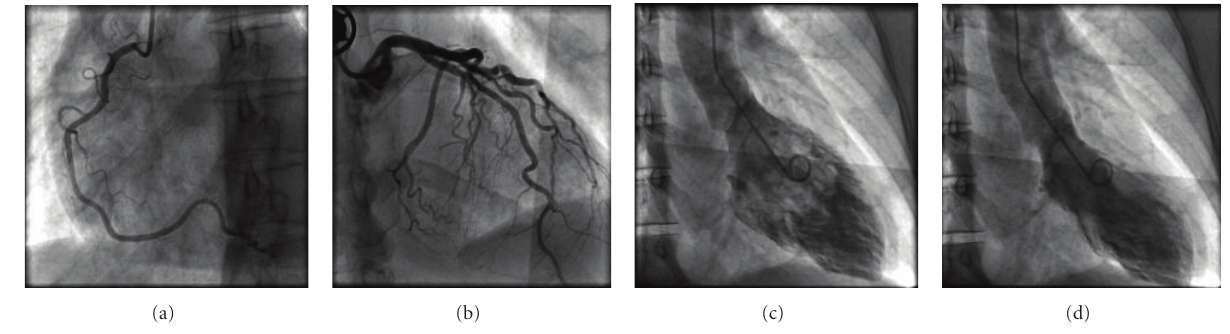
Figure 2: Left ventricular angiogram showing apical ballooning (Case